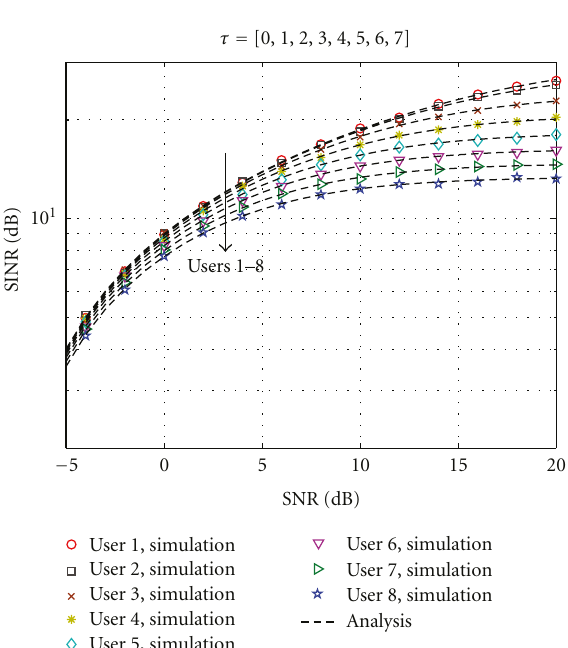
Figure 3: SINR versus SNR, τ =